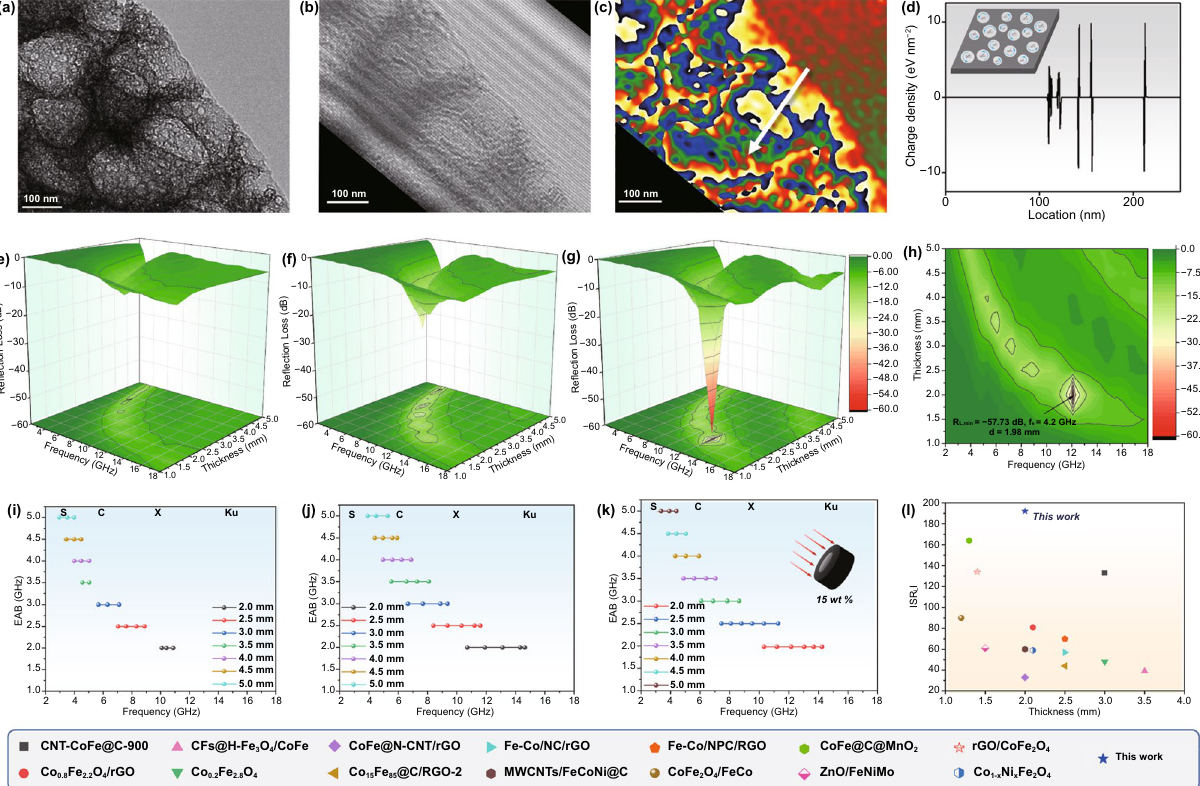
Fig. 2 Nanodomain variable capacitors and electromagnetic wave (EW) attenuation performance. a‑b HR-TEM and corresponding hologram images. c Charge density map. d Charge density profile along the white arrow and scheme of nanodomain variable capacitors (insert). e‑g The electromagnetic parameters, 3D RL values of Fe@PCS, Co@PCS, and CoFe@PCS. h 2D RL projection of CoFe@PCS. i‑k Effective